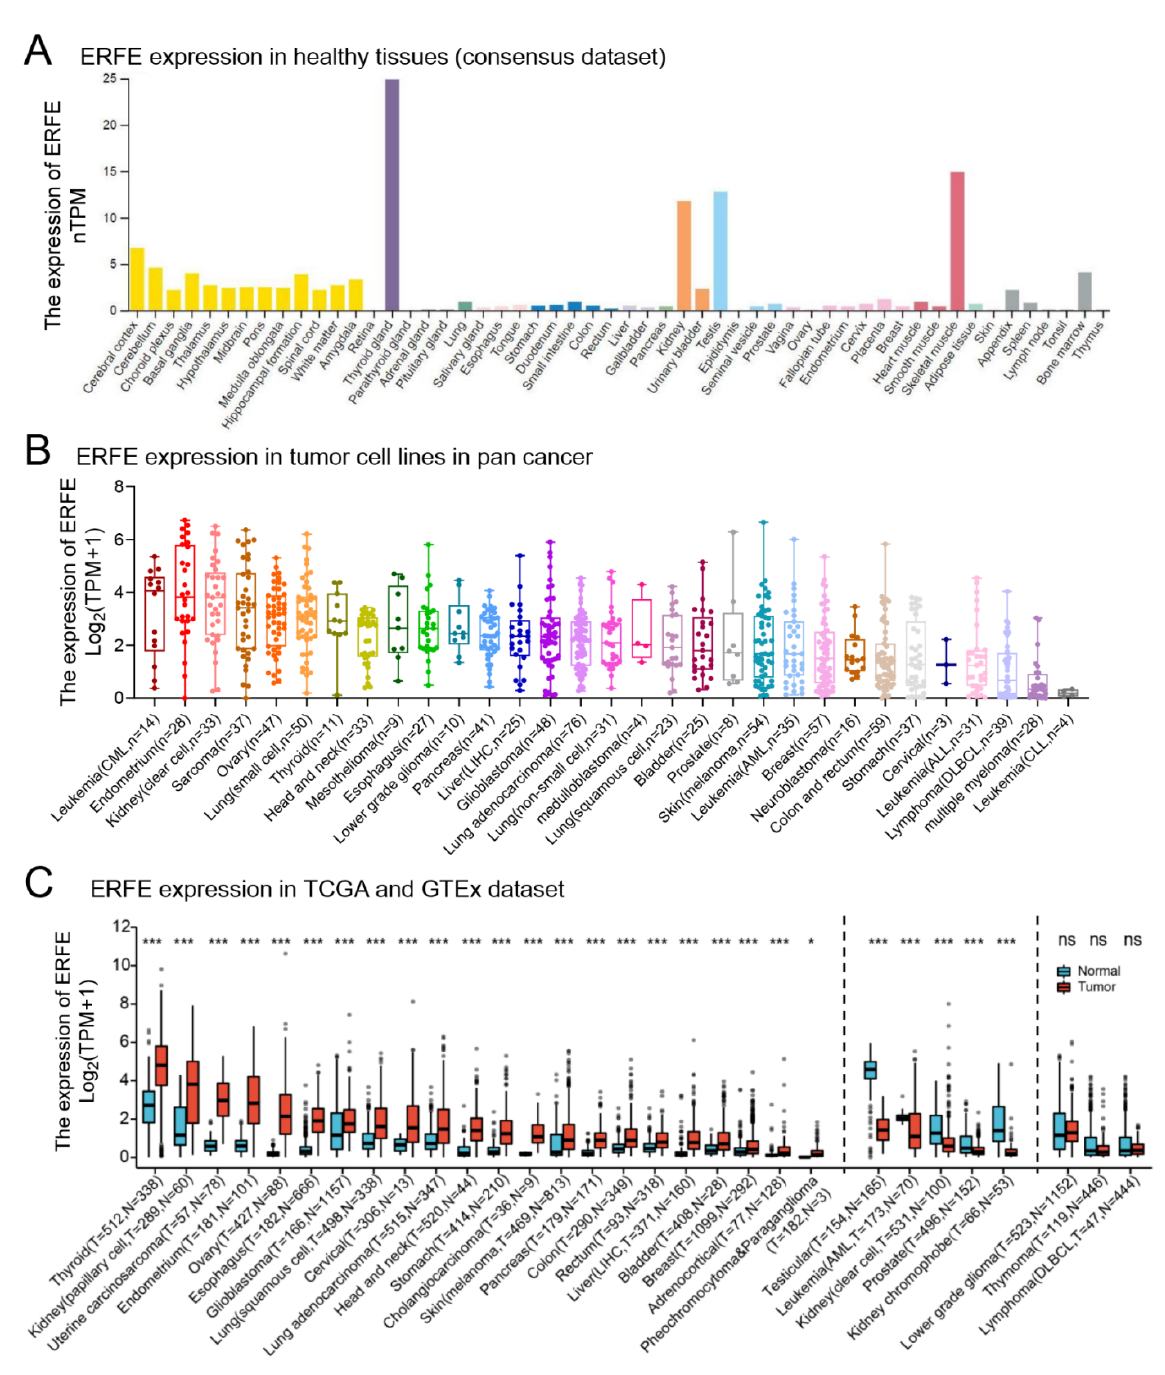
Figure 1. Expression levels of the ERFE gene in human normal tissues and pan-cancer. ( A ) Consensus ERFE healthy tissue expression based on datasets of HPA, GTEx, and FANTOM5 (function annotation of the mammalian genome). ( B ) The expression distribution of the ERFE gene was visualized in 31 cancer types containing 1018 tumor cell lines from the CCLE dataset. ( C ) The expression distribution of the ERFE gene was visualized between the investigated 33 cancer types from the TCGA project and normal tissues from the GTEx database. The expression difference between the tumor and healthy groups was compared using the Wilcoxon rank sum test. Asterisks (*) stand for significance levels. ns, p ≥ 0.05; * p < 0.05; *** p < 0.001. Abbreviations: PCPG, pheochromocytoma and paraganglioma; T, tumor; N, normal tissues; CCLE, Cancer Cell Line Encyclopedia dataset; FANTOM5, Functional ANnoTation Of the Mammalian genome project 5.